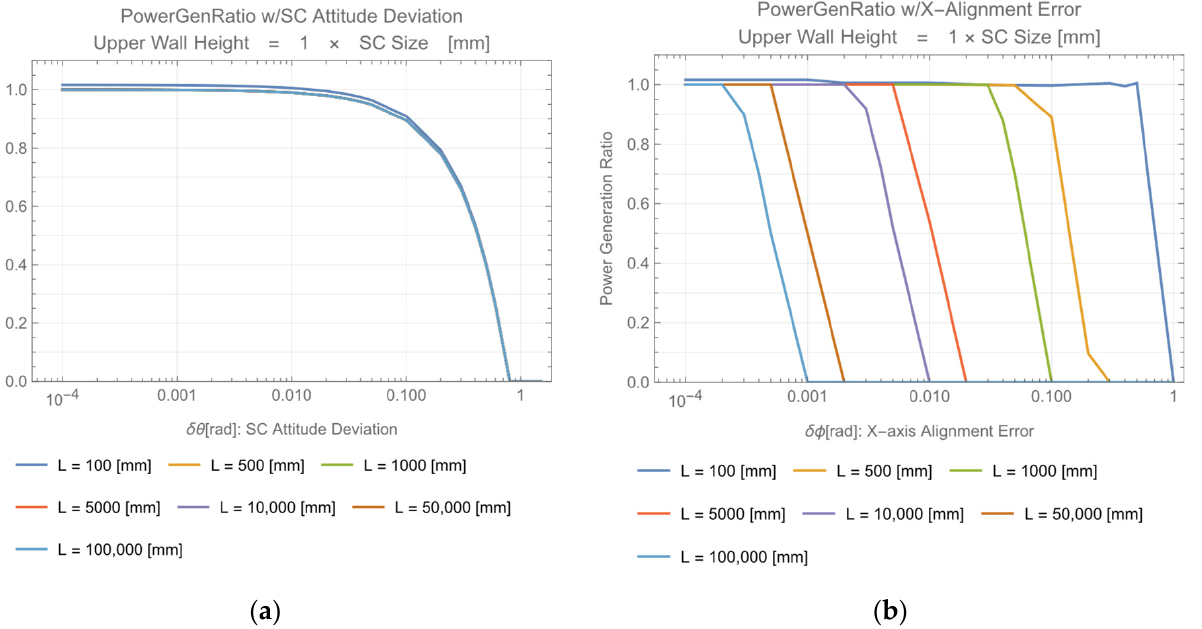
Figure 16. Beam Energy Confinement by Upper and Lower Wall Mirror (Upper Wall Height = SC ): ( a ) power generation ratio calculation for the tilt angle relative to the beam; ( b ) for the X(Y) deviation of the beam.